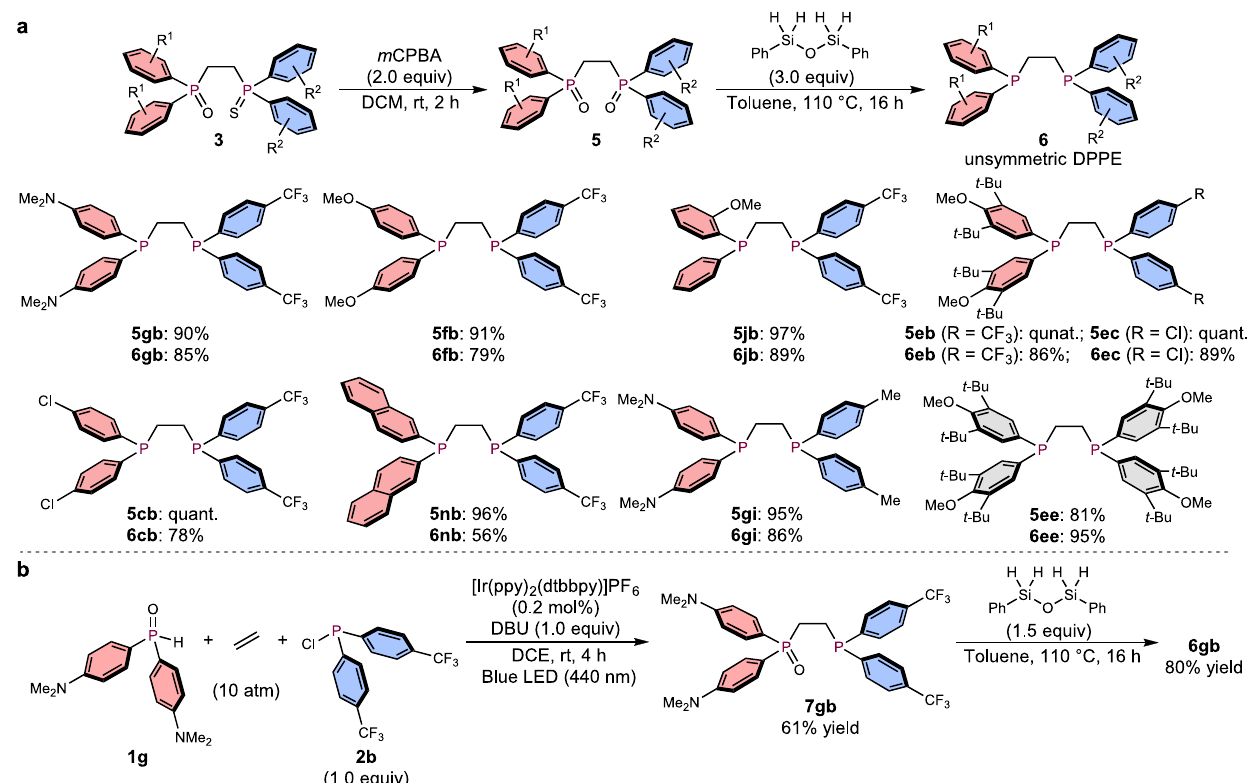
Fig. 7 | Synthetic applications. a Conversion of mixed P=O/P=S DPPE derivatives to DPPE dioxides, and reduction to DPPEs. b Alternative method for the direct reduction of monooxo DPPE